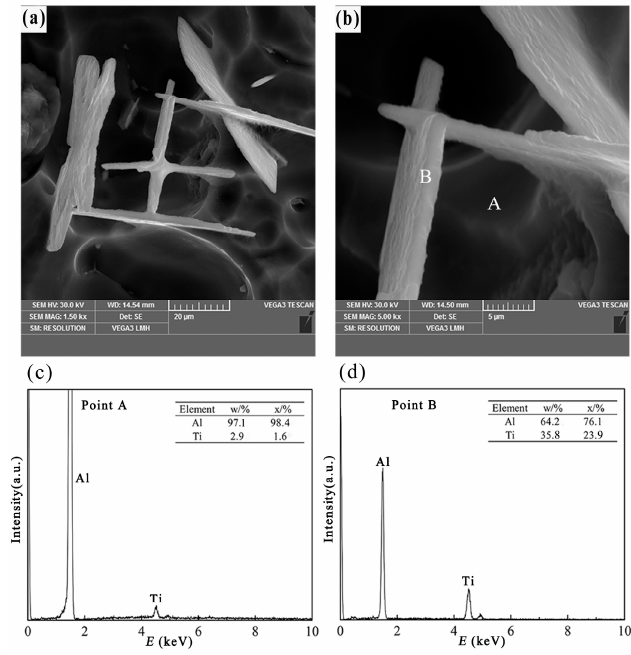
Figure 8. Three-dimensional morphology and point scan elements analysis of flake-like TiAl 3 , ( a , b ) three-dimensional morphology of the flaky TiAl 3 particle; ( c ) EDS spectra of point A; ( d ) EDS spectra of point B.